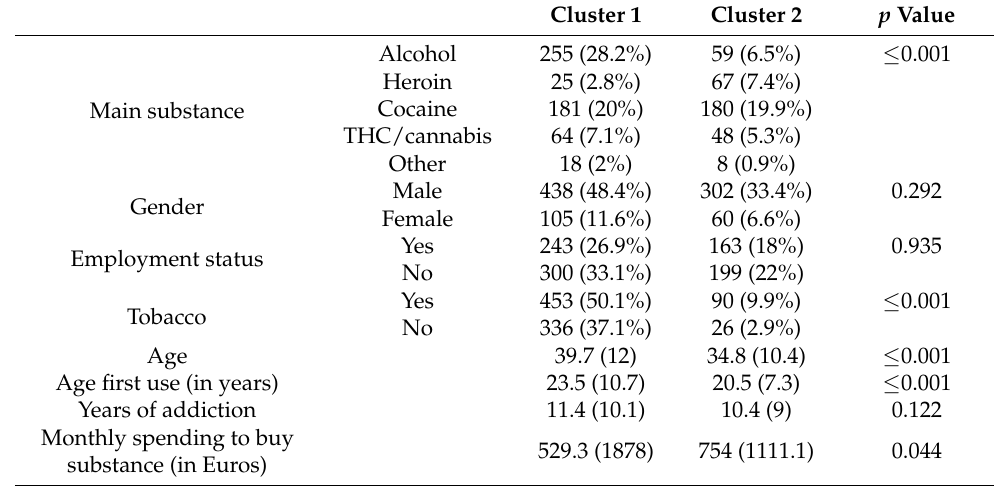
Table 3. Characteristics of the patients divided into the two different